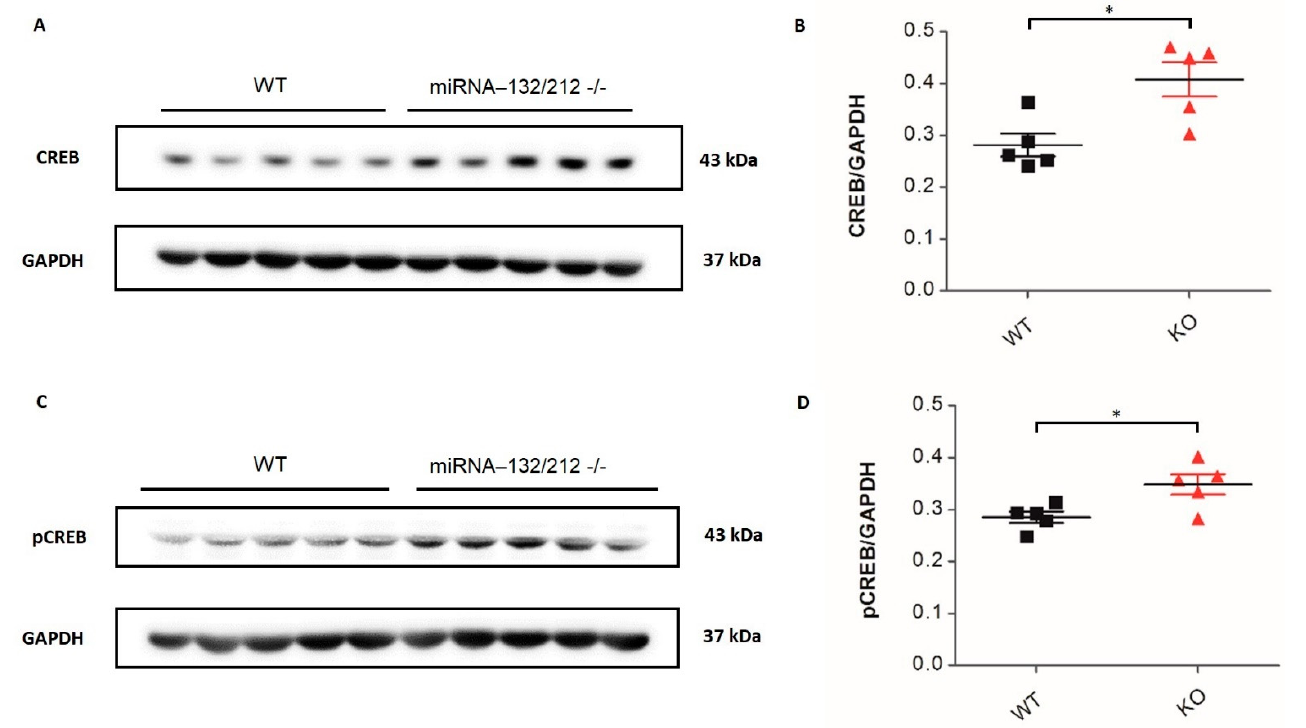
Figure 7. Knockdown of the miRNAs 132 and 212 genes alters protein levels and phosphorylation of CREB in adult mouse hippocampus. Western blots from hippocampal tissues were used to examine the levels of total and phosphorylated CREB. ( A ) Demonstrative blots and ( B ) expression levels of total CREB and GAPDH, showing significant enhancement of total CREB in miRNA-132/212 − / − (KO), in comparison to wild type (WT) (* = p < 0.05; t -test). ( C ) Illustrative blots and ( D ) expression levels of phosphorylated CREB and GAPDH showing significant enhancement of phosphorylated CREB in miRNA-132/212 − / − tissue in comparison to WT (* = p < 0.05; t -test). Results are shown as fold change normalized to GAPDH protein levels. Data are shown as mean ± SD, n = 5/group. kDa = kilodalton.